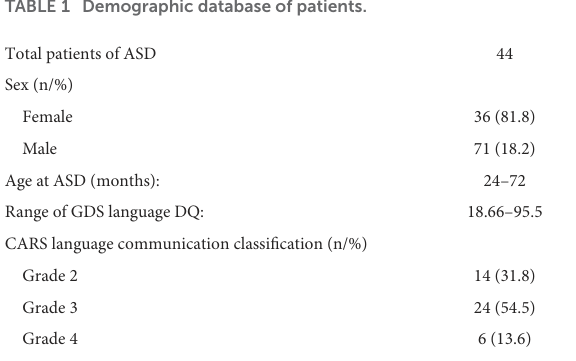
TABLE 1 Demographic database of patients.